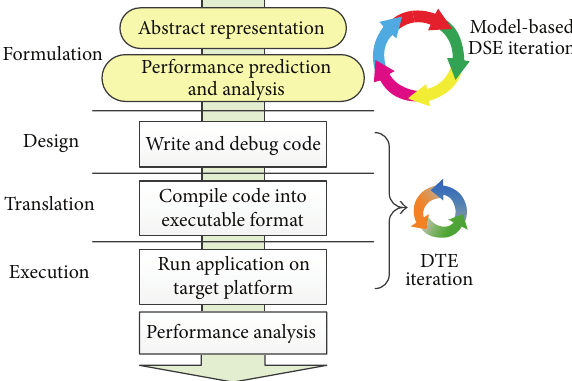
Figure 1: Formulation, design, translation, execution (FDTE) model for FPGA application